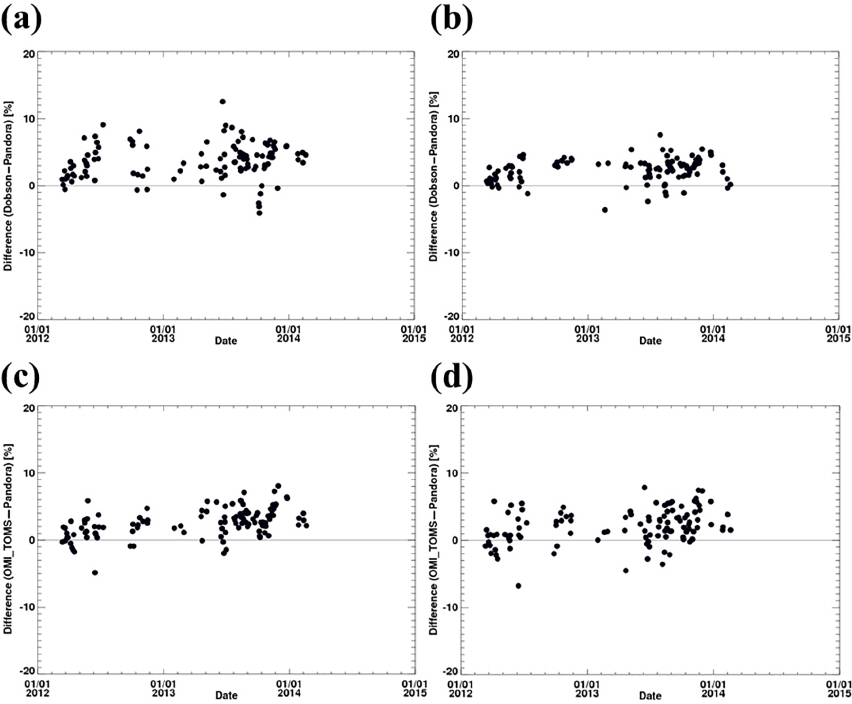
Figure 6. Time series of relative differences in daily TCO values from Pandora and those from (a) Dobson, (b) Brewer, (c) OMI-TOMS, − TCO Pan and (d) OMI-DOAS ( TCO inst [%]). Gaps in the time series indicate at least one missing value in the observations from the four TCO Pan